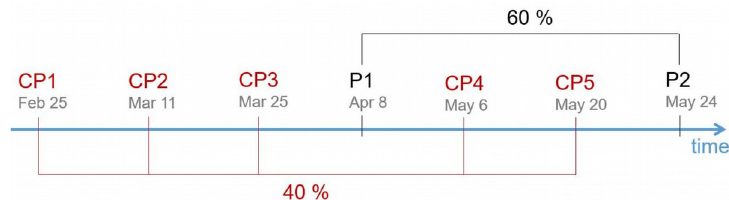
Figure 1. Distribution and relative value of evaluations throughout the year (CP = practical cases, P = partial